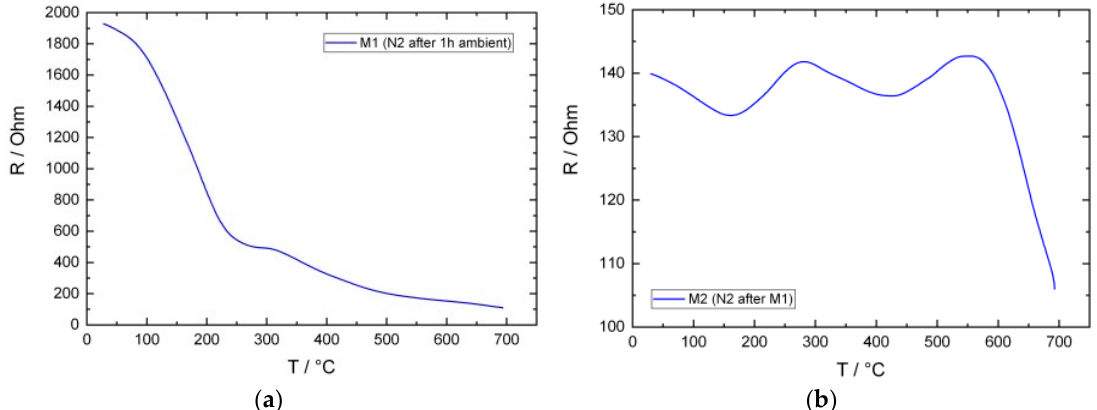
Figure 3. R(T) in N 2 after exposure to ambient air ( a ), subsequent measurement ( b ).